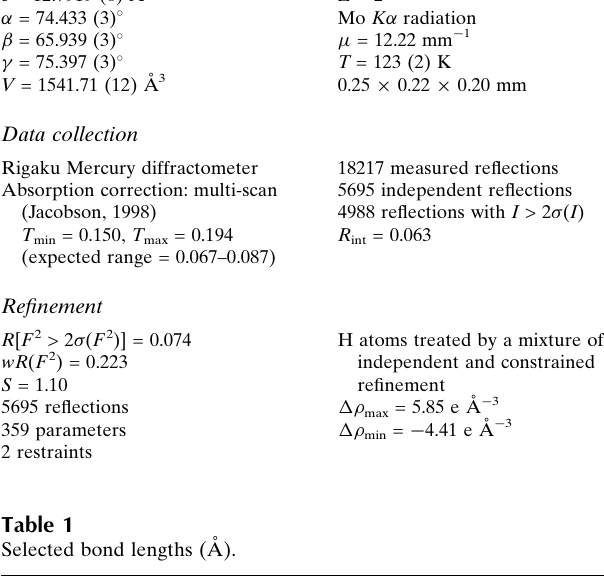
Rigaku Mercury diffractometer Absorption correction: multi-scan